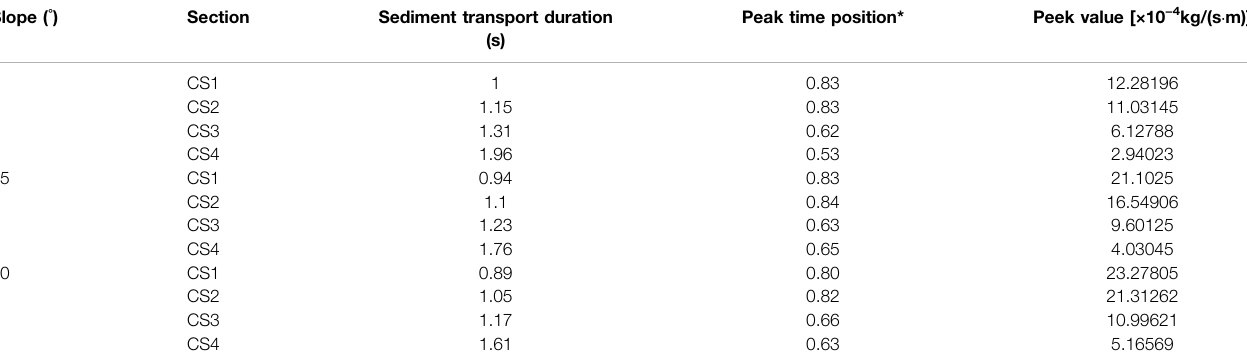
TABLE 2 | The time of sediment transport and peek.